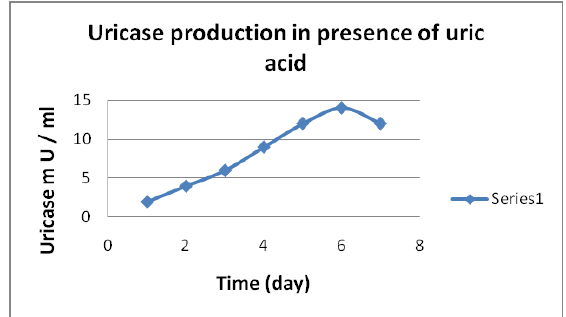
Figure 8. Production of uricase at different time intervals when uric acid was present in the medium.